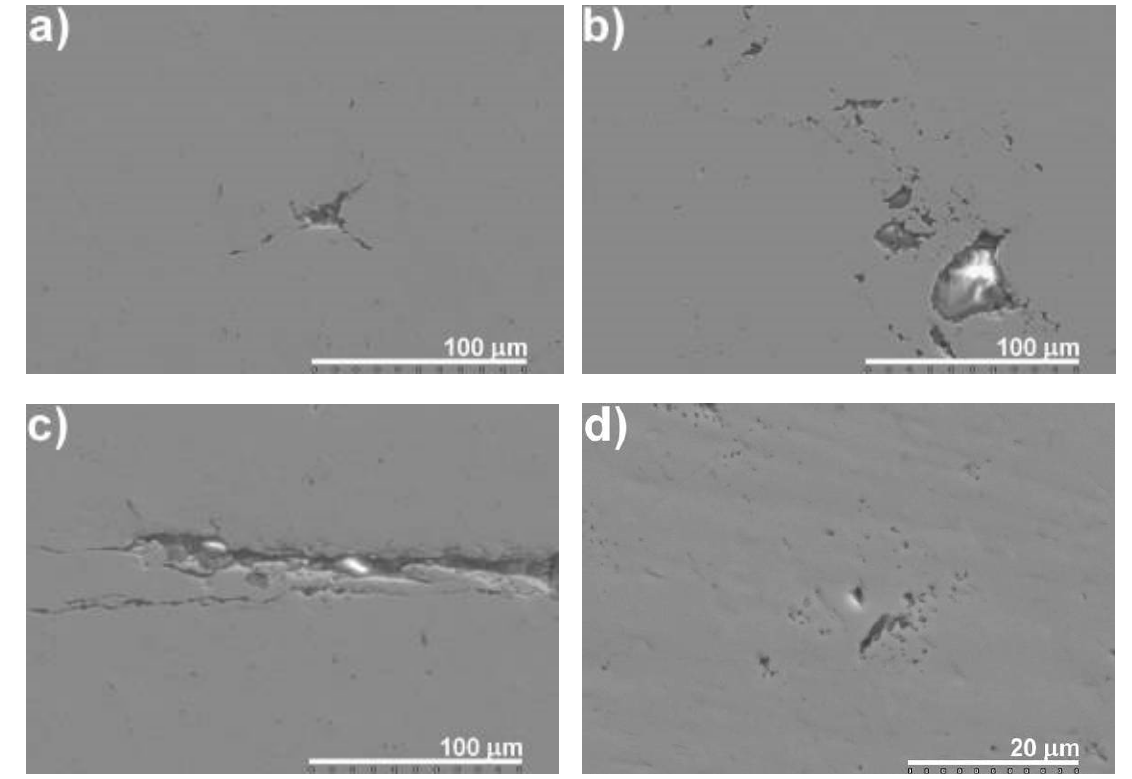
Figure 11. Example results of structural defects visible using SEM: ( a ) V2 transverse section, ( b ) V3 transverse section, ( c ) V2 longitudinal section, ( d ) another area of V2 transverse section visible in higher magnification.